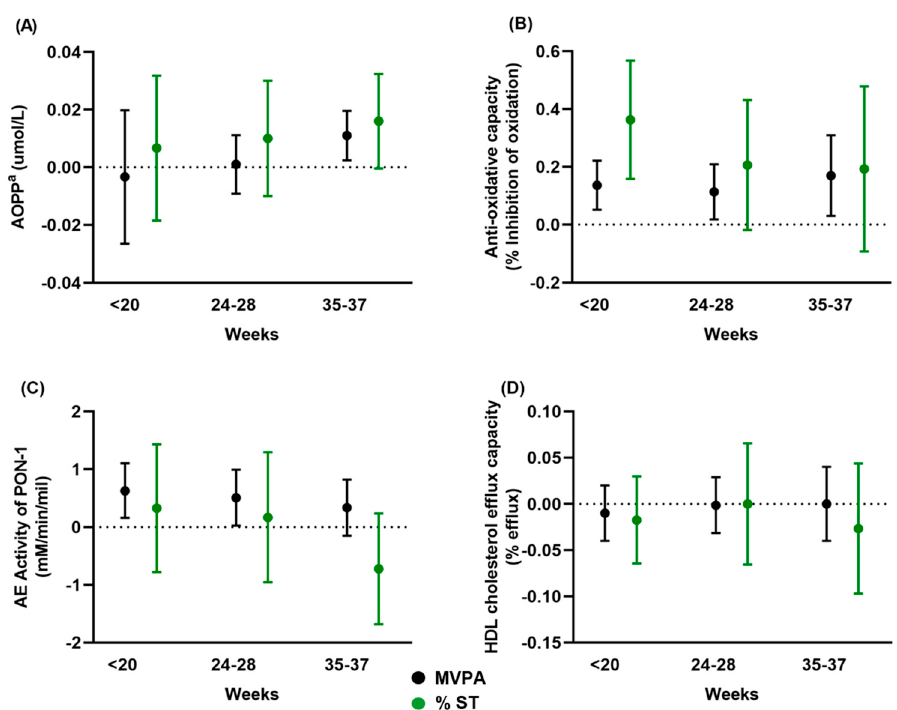
Figure 3. Regression coefficient estimates with 95% confidence intervals of the association between moderate-to-vigorous physical activity (MVPA= black) and % sedentary time (%ST = green) and cord blood levels of advanced oxidation protein products (AOPP) ( A ), anti-oxidative capacity (% inhibition of oxidation) ( B ), AE activity of PON-1 ( C ), and HDL cholesterol efflux capacity ( D ). a Log transformed values were used in the regression analyses.